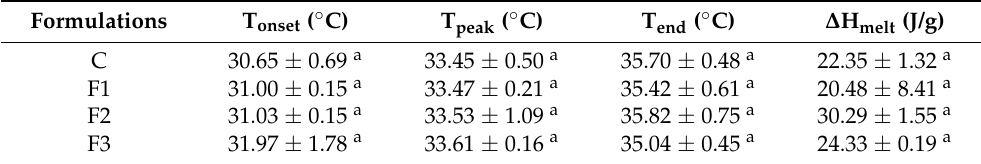
Table 7. Melting properties of control and GABA-enriched dark